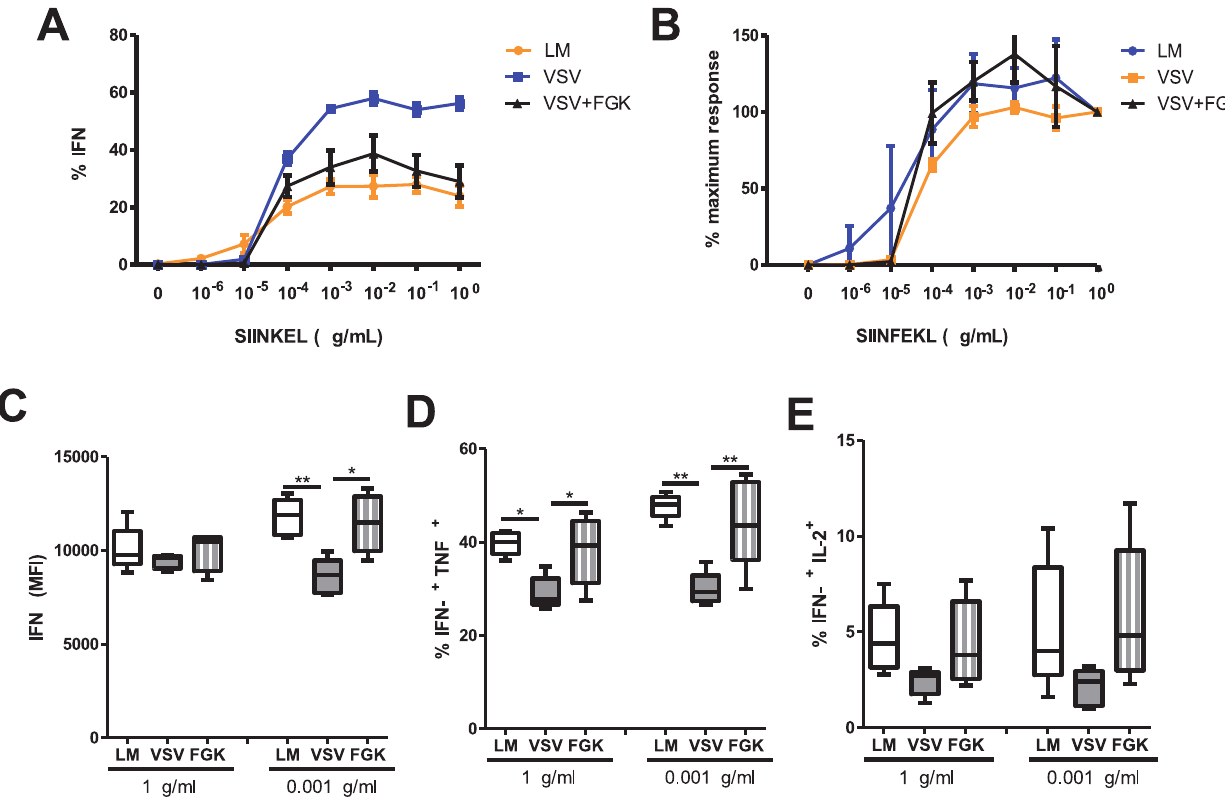
Figure 4. FGK4.5 treatment during VSV vaccination enhances the functional avidity and poly-functionality of secondary effector CD8 + T cells. C57BL/6 mice were i.v. infected with 2 6 10 3 cfu LM-ova, or with 2 6 10 5 pfu VSV-ova, or 2 6 10 5 pfu VSV-ova plus treated i.p. with 100 m g FGK4.5 one day post infection. Ninety days after primary challenge mice were re-challenged with 5 6 10 4 cfu LM-ova. Seven days later the sensitivity to antigen and functionality of the secondary effector CD8 + T cell response was assessed by intracellular cytokine staining. Spleen lymphocytes were stimulated with one to 0.00001 m g/mL of the SIINFEKL peptide. Cells were fixed and rendered permeable before staining with antibodies IFN c , TNF a , and IL-2. We tested (A) the percent IFN c and (B) the percent IFN c over the maximum; at all peptide dilutions. Next we analyzed the (C) geometric mean fluorescence intensity (MFI) of the CD8 + T-cells for IFN c , the (B) percent of IFNy expressing cells also expressing TNF a and (E) the IFN c expressing cells also expressing IL-2. Results shown for 0.001 and 1 m g/mL SIINFEKL only (Figures C, D, E). Statistical significance was determined using a one-way ANOVA with a Bonferroni’s post-test ***p , 0.001**p , 0.01; *p , 0.05). Each group contained 4–5 mice per group.